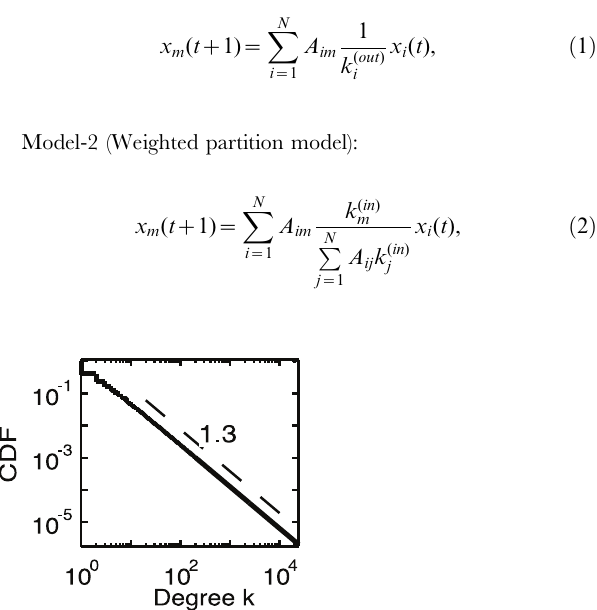
Figure 1. The cumulative distribution function of degree of the artificial networks. We confirm that degree obeys the power law distribution with exponent 2 1.3, namely, P k ( k ) ! k { 2 : 3 .